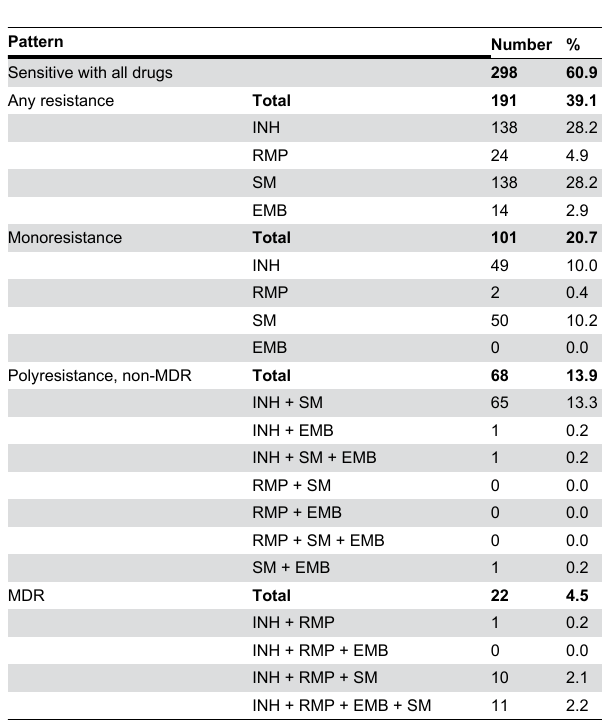
Age (median, range)